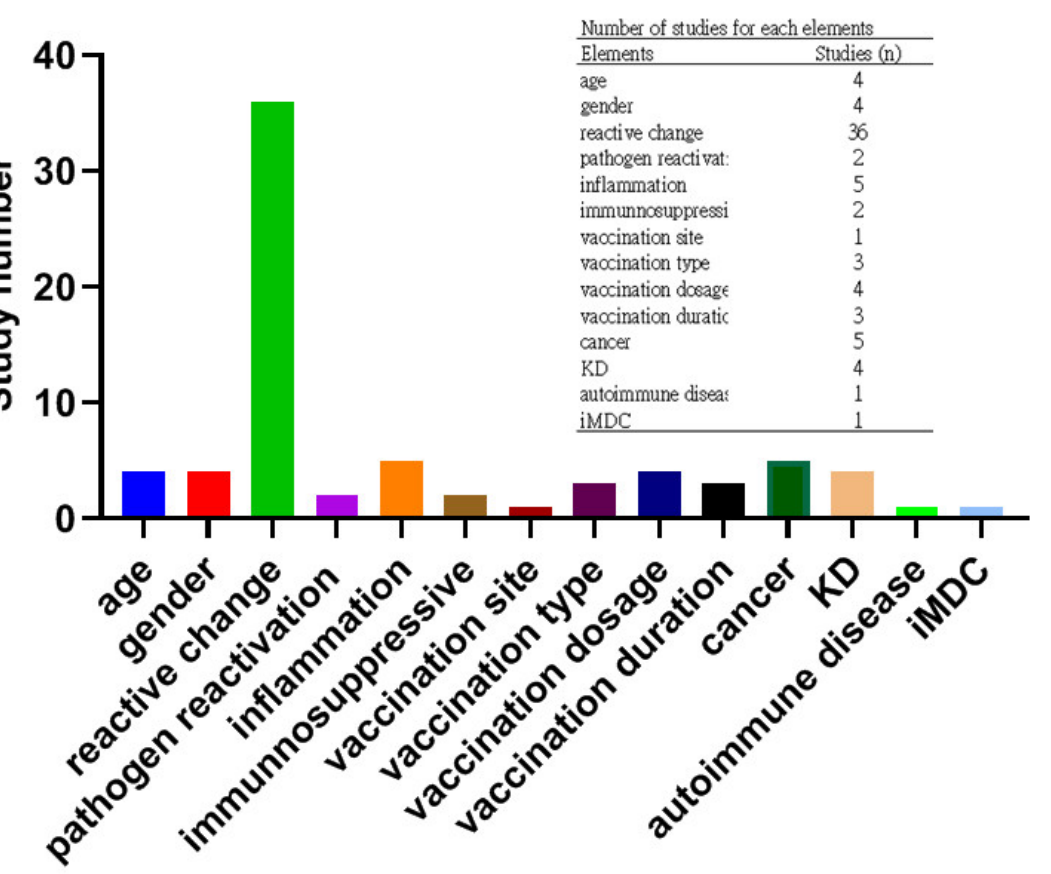
Figure 2. Study number regarding each element for C19-VAL. Other vaccine associated adverse effects were indicated as other adverse effects